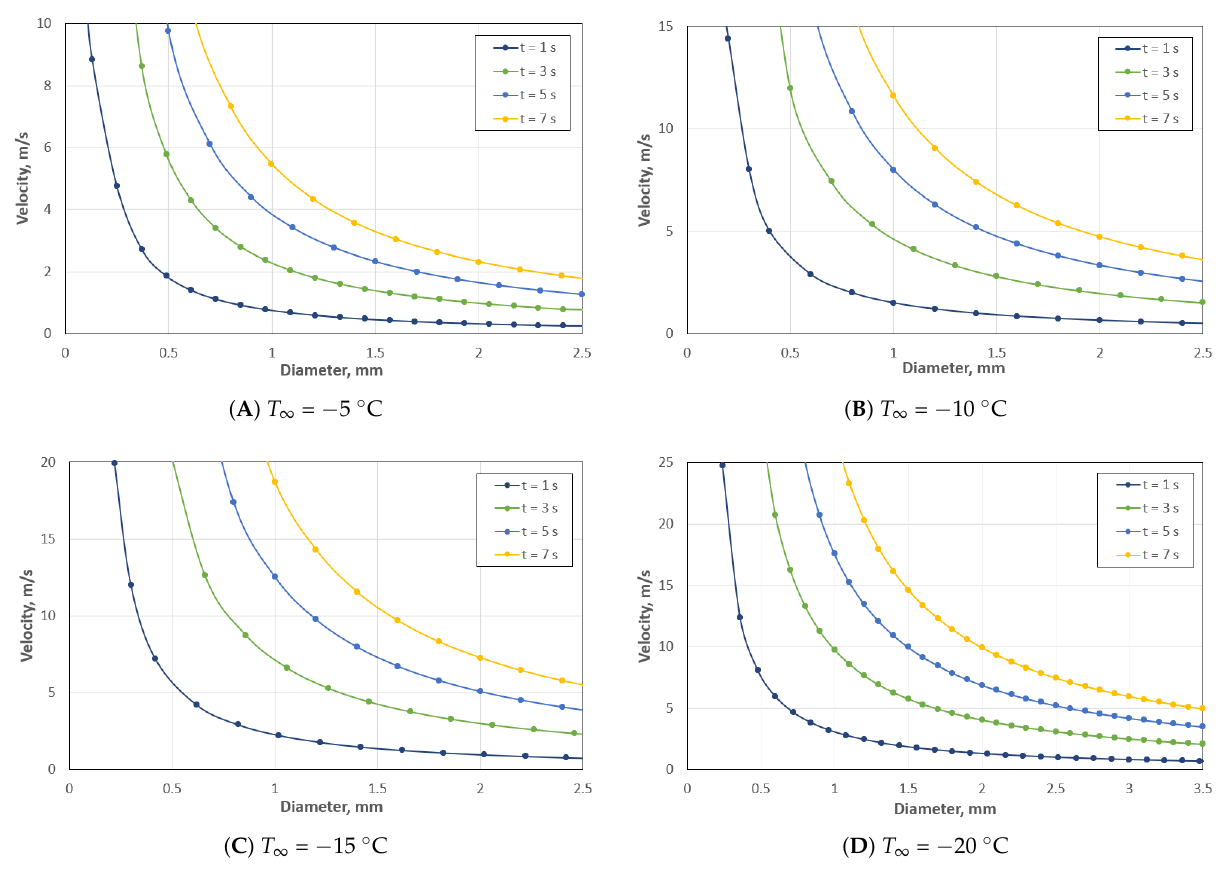
Figure 5. Critical velocity vs. droplet